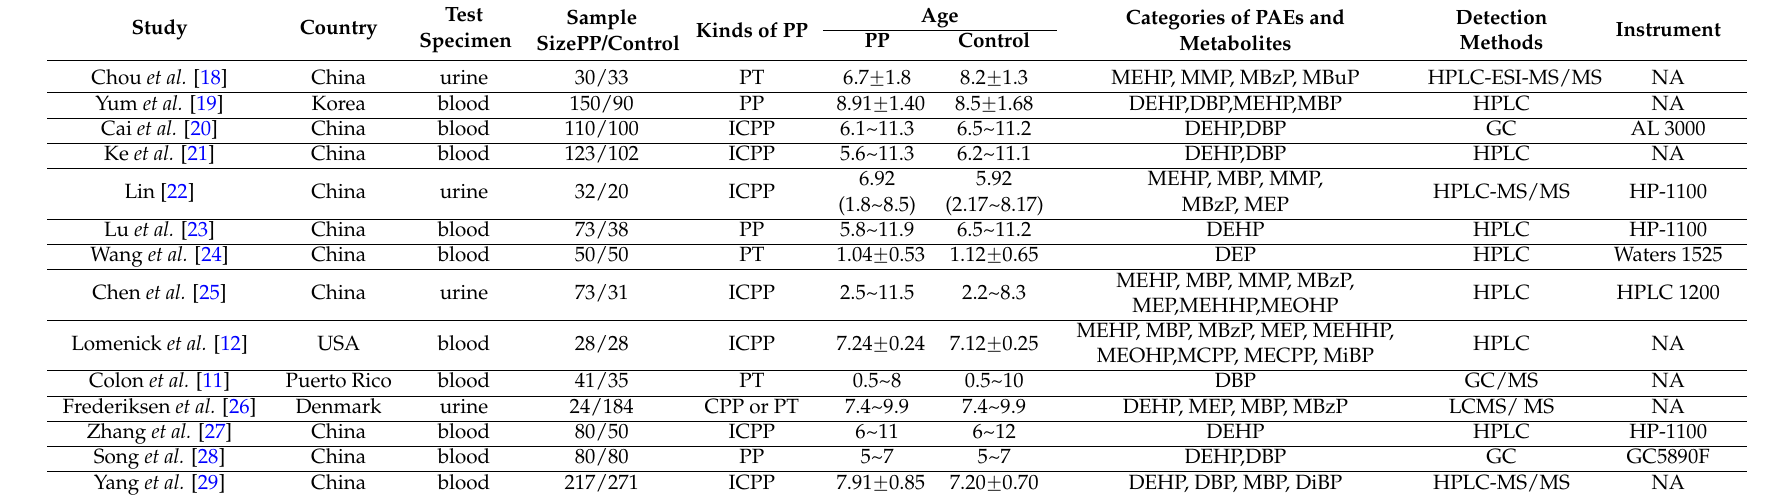
Table 1. Characteristics of studies included in the